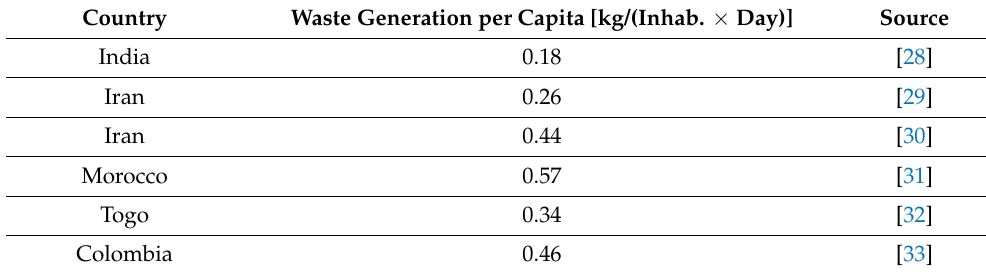
Table 1. Waste generation rate per capita in rural communities of developing countries.